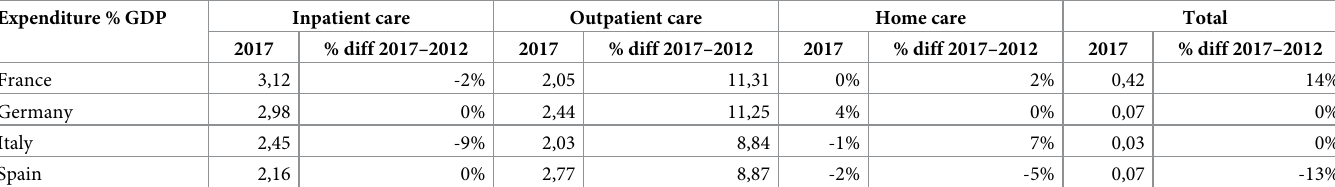
Table 1. Health expenditure (public and private) reported as percentage of the GDP in 2017 and in percentage variation with 2012. Expenditure % GDP